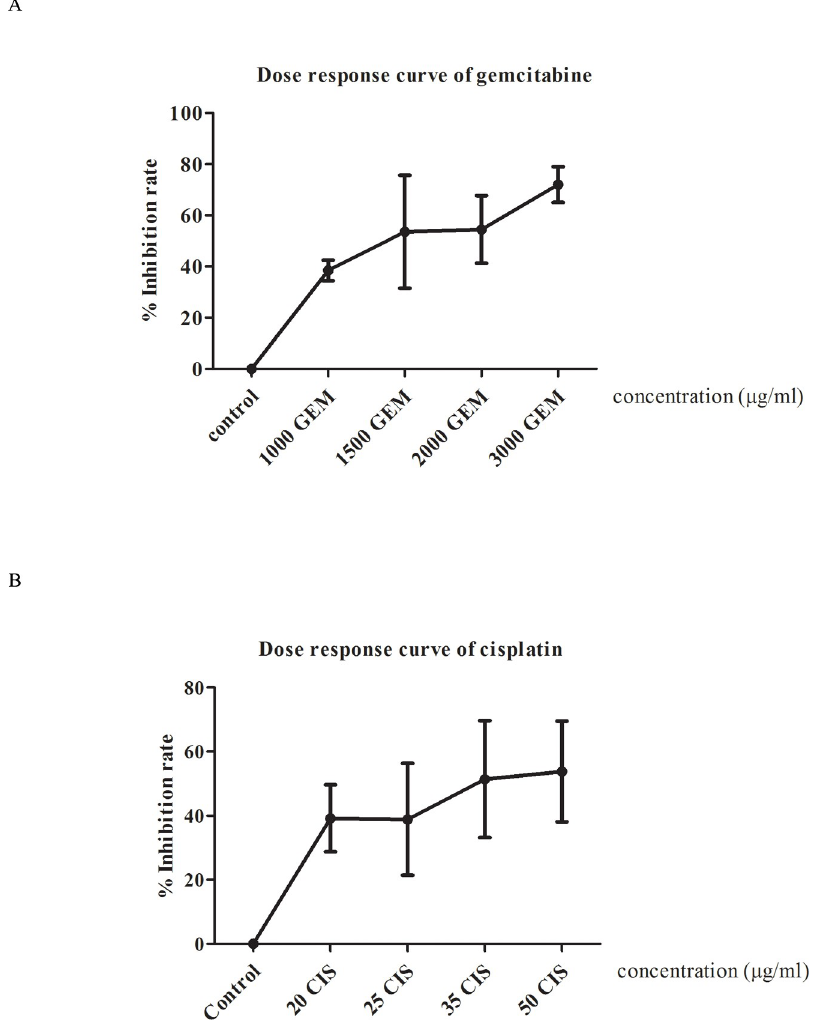
Fig 2. Dose response analysis of gemcitabine and cisplatin. X axis represents each concentration of each drug. Y axis represents %IR of each concentration in each drug. (A) Represent dose response curve of gemcitabine in concentration 1000, 1500, 2000 and 3000 μ g/ml were tested to observed %IR. (B) Elucidate dose response curve of cisplatin in concentration 20, 25, 35, 50 μ g/ml of cisplatin were also tested to observed %IR.